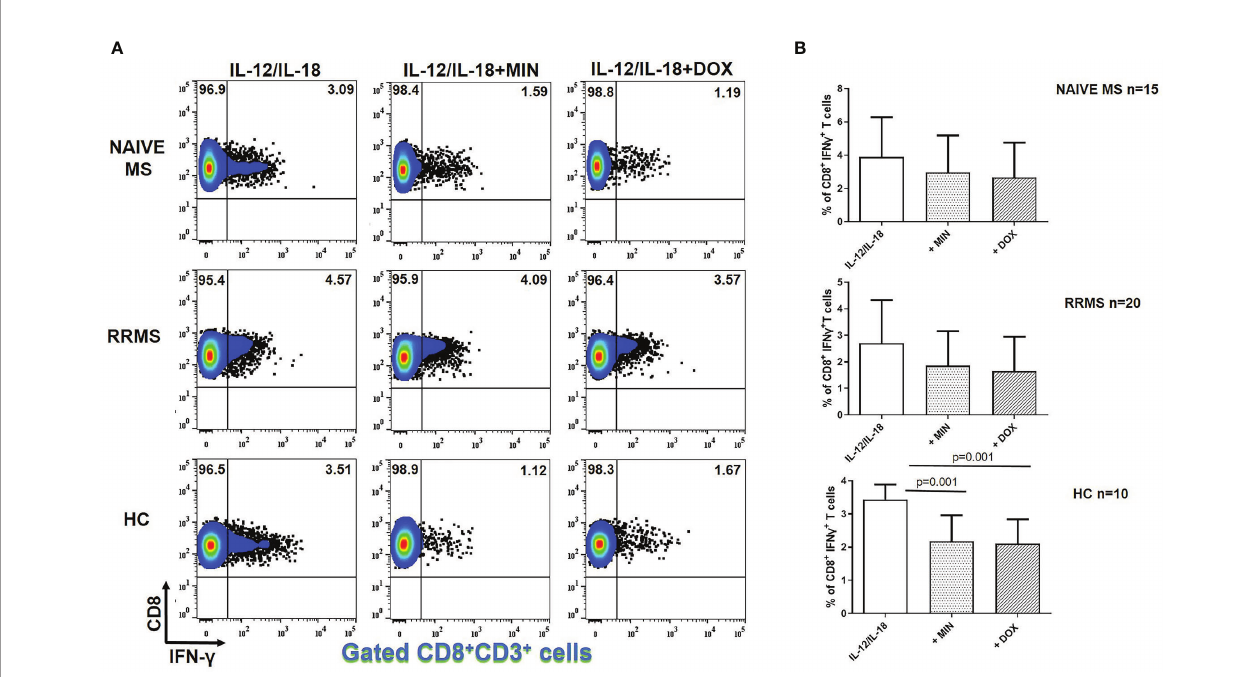
FIGURE 2 | Tetracycline-mediated inhibition of CD8 + IFN g + T cells. PBMCs from naïve MS patients (n=15), RRMS patients (n=20) and HCs (n=10) were seeded in cell culture plates (1 x 10 6 per well) and stimulated with IL-12 plus IL-18 (IL-12/IL-18), IL-12/IL-18 plus minocycline (MIN) and IL-12/IL-18 plus doxycycline (DOX) for 5h. Cells were collected, washed, surface stained with appropriate monoclonal antibodies an analyzed for intracellular IFN- g production by fl ow cytometry (see also methods section). Individual cell subsets were sub-gated according to expression of CD3 and CD8 surface epitopes. (A) Flow cytometry dot-plots showing the frequency of CD8 + IFN g + T cells in IL-12/IL-18, IL-12/IL-18/MIN and IL-12/IL-18/DOX treated cells from representative MS cases and HCs. (B) Box and whiskers graphical representation showing signi fi cant reduction in the percentages of IFN g -producing CD8 + T cells in the presence of tetracyclines in HCs but not naïve MS and RRMS